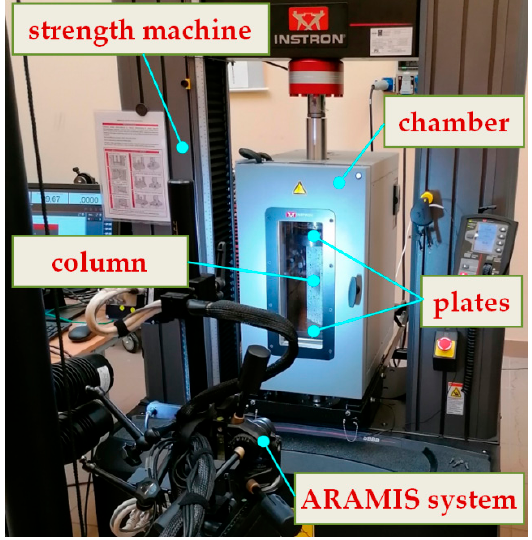
Figure 2. The testing stand equipped with ARAMIS ® system (Braunschweig, Germany).